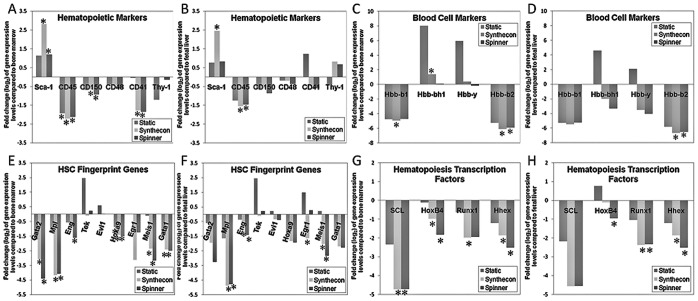
Differences in LKS cell gene expression.Fold changes of lineage-specific genes differentially regulated in Lin-ckit+Sca-1+ cells derived from Static and bioreactor culture conditions (Synthecon and Spinner flask) relative to LKS cells purified from BM and FL. Expression levels (n = 3) were compared for genes encoding cell surface markers of hematopoiesis (A, B), and blood cell markers (erythropoiesis) (C,D), the HSC “fingerprint” genes of Chambers et al [18] (E,F) and critical hematopoietic transcription factors (G,H). The expression levels of hematopoietic markers (A,B) and blood cell markers (erythropoiesis) (C,D) were primarily down-regulated under ESC conditions as compared to BM and FL. When compared to BM and FL, the majority of the HSC fingerprint (E,F) and HSC transcription factor gene expression (G,H) was also down-regulated. (*) represent gene- expression values of statistical significance (p<0.05).